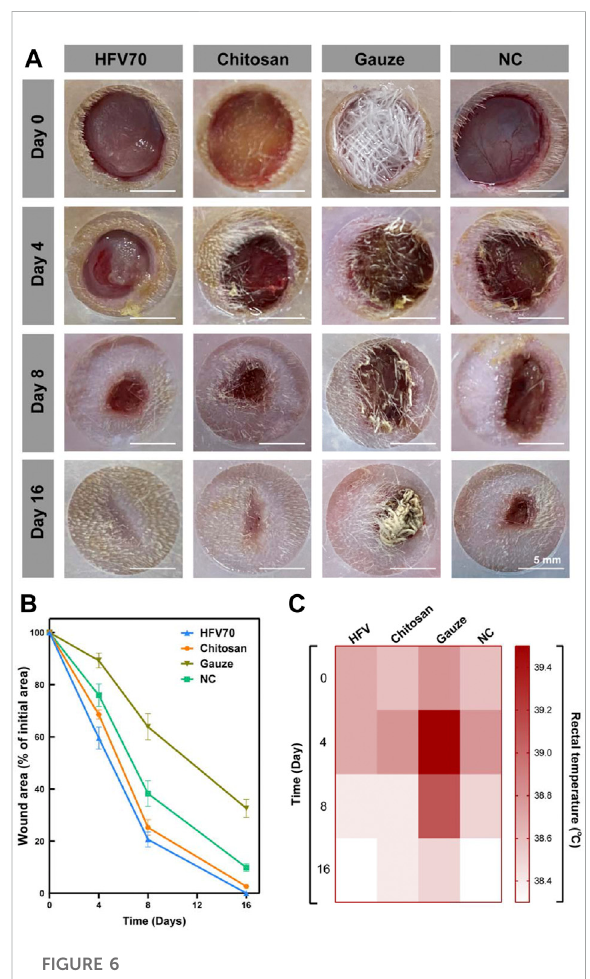
FIGURE 6 Treatment effect evaluation in the rat full-thickness skin defect model. (A) Images of initial wounds covered with different dressings and the subsequent images of the wounds at different time points (4, 8, and 16 days). (B) Wound area changes in each group. (C) Body temperature changes in each